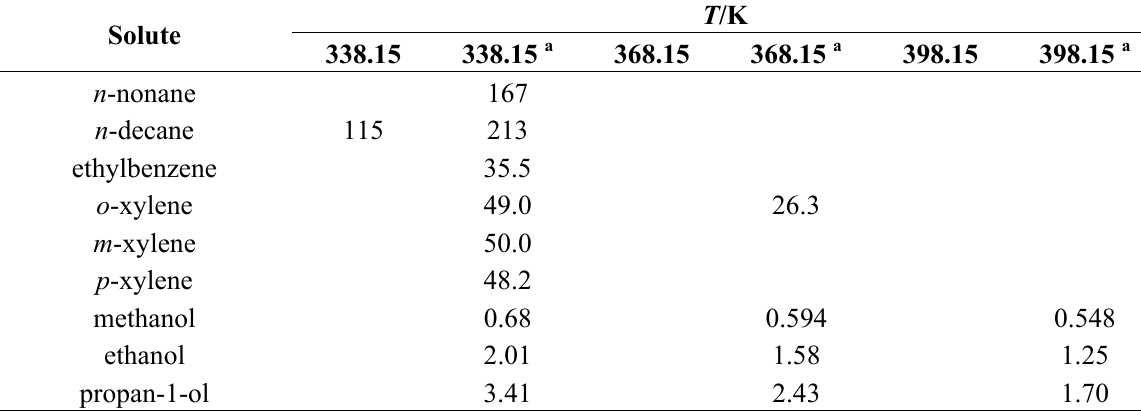
Table 3. The Experimental activity coefficients at infinite dilution, ∞ the IL [BMPYR][Br] (15.73 w %) and IL {[BMPYR][Br] (14.95 w %) + β -CD (14.81 w %)} at different